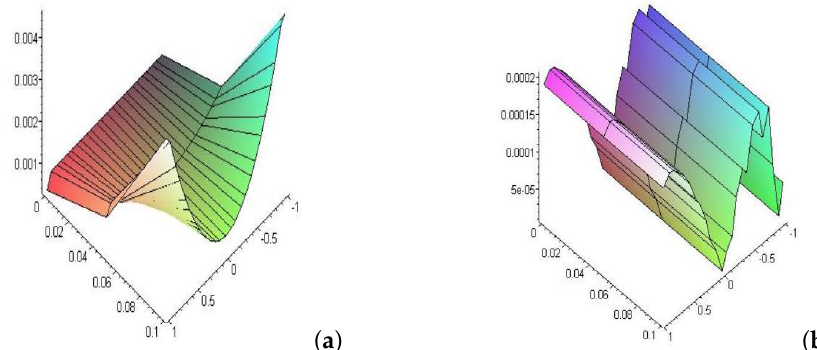
Figure 2. ( a ) Shows the error for the nonlinear case at β = 0.01 and ( b ) shows the corresponding error for the linear case at β = 0.01.